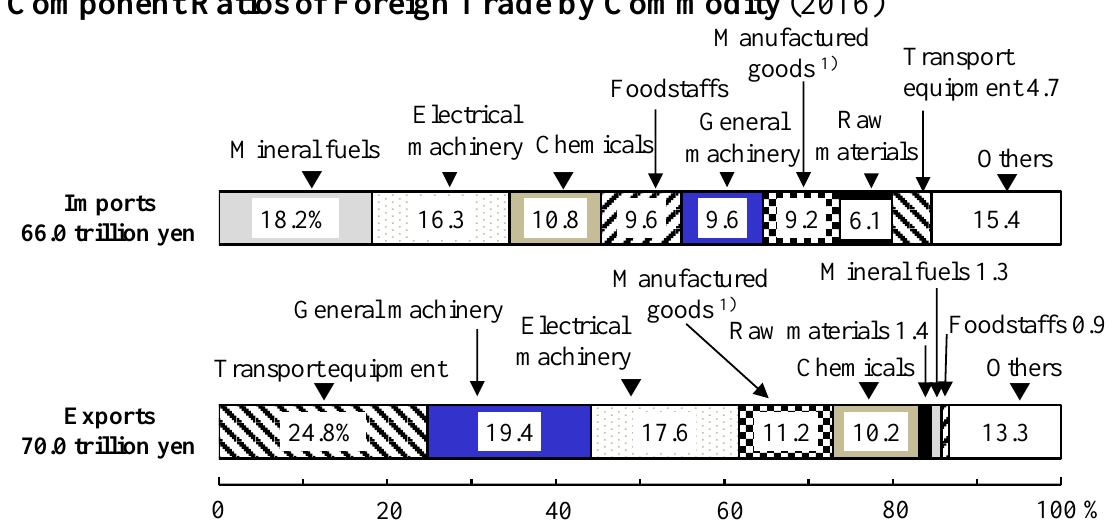
Component Ratios of Foreign Trade by Commodity (2016)